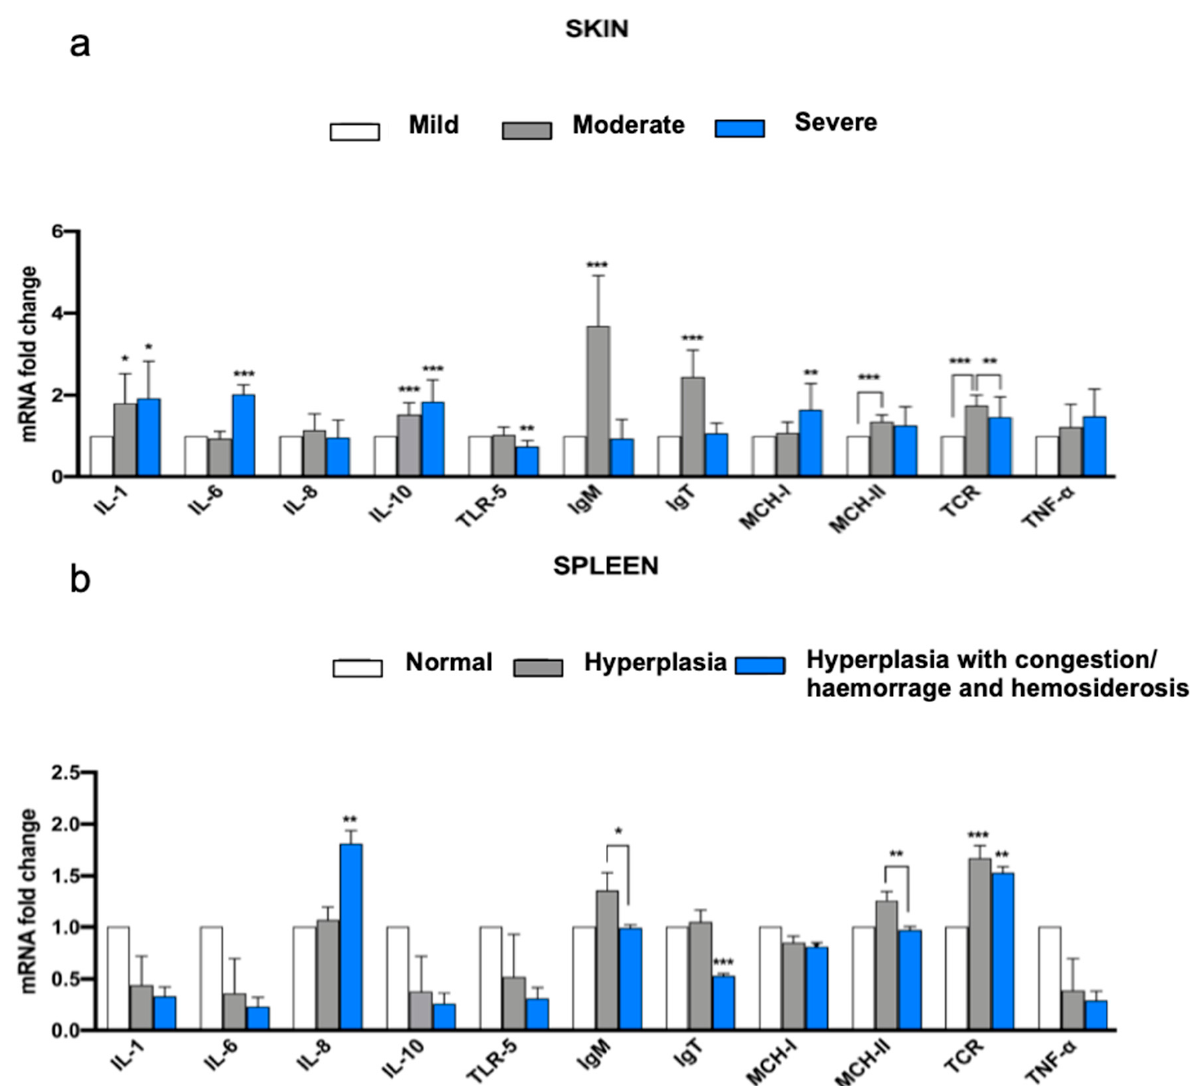
Figure 3. Fold change ratio in relative RNA expression of immuno-related genes analyzed in the skin ( a ) and splenic ( b ) samples. Skin and splenic samples were divided into groups based on the histological categories of the skin and splenic lesions (respectively, “Mild”, “Moderate” or “Severe” for skin and “Normal”, “Hyperplastic” and “Hyperplastic with congestion/haemorrhage and hemosiderosis” for spleen). “Mild” and “Normal” groups are the reference groups (gene expression = 1; white column) for skin and spleen samples, respectively. * = p < 0.1; ** = p < 0.05; *** = p < 0.01.